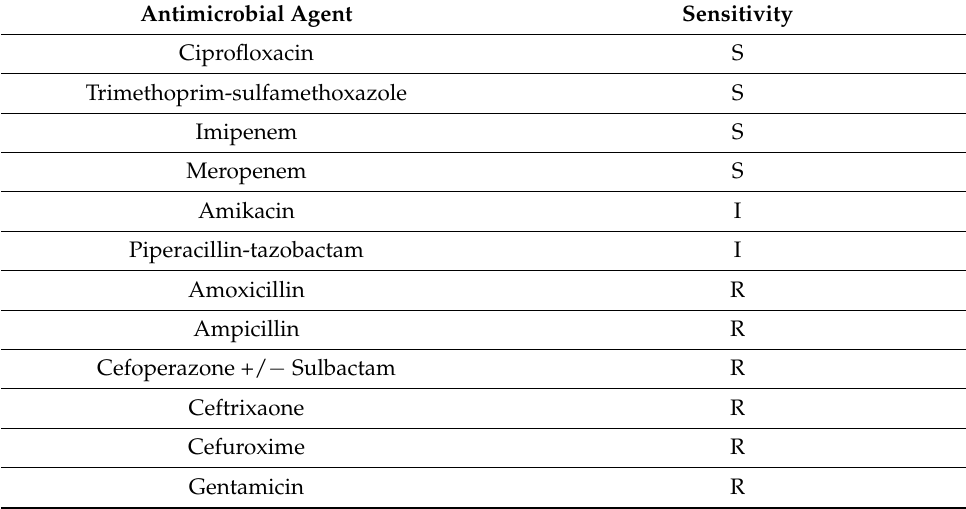
Table 1. Antibiotic susceptibility of Serratia marcescens in our